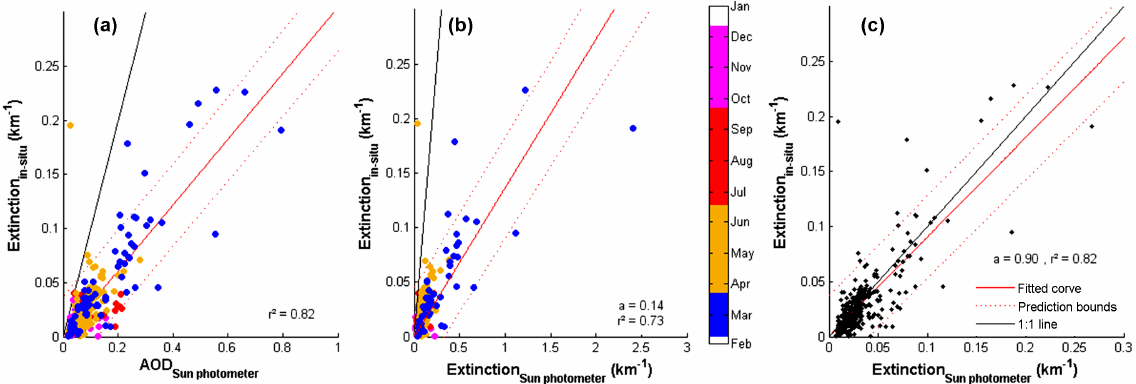
Figure 4. In situ extinction coefficient at 675nm calculated from nephelometer and MAAP measurements vs. (a) sun photometer AOD and (b) sun photometer extinction (km − 1 ) colour-coded by season. (c) Same comparison of extinction coefficients using linear aerosol vertical decreasing assumption. Full and dashed red lines correspond to the fitted line and prediction bounds respectively and the black line to the 1:1